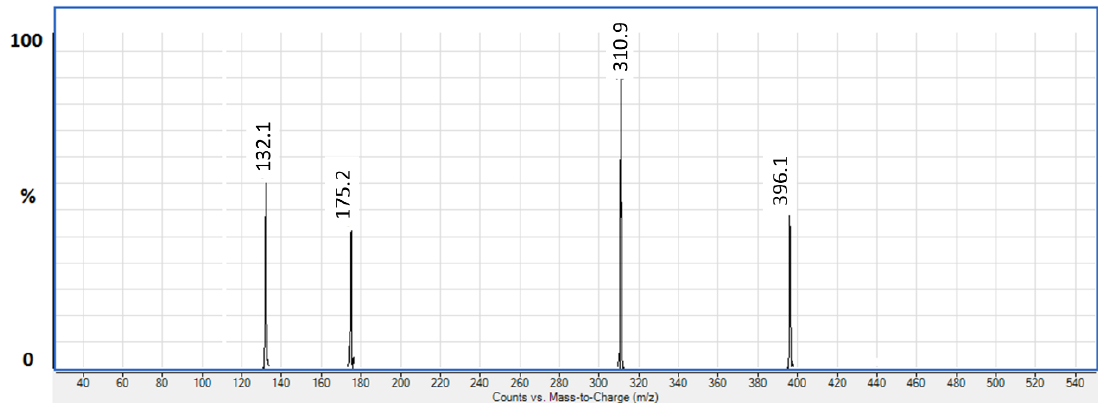
Figure 2. Product ion mass spectrum of folic acid ( m / z 440.40 → 310.90) in the negative ionisation.